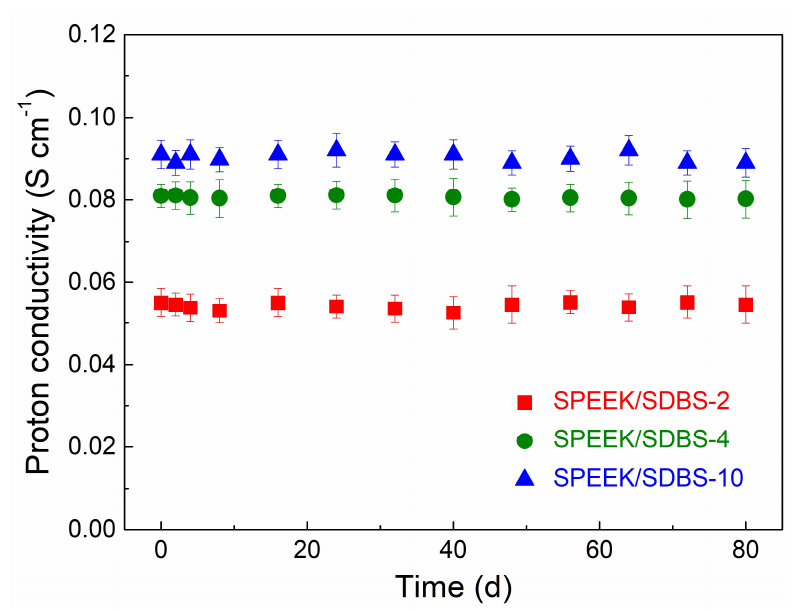
Figure 7. Proton conductivity of the SPEEK/SDBS-10 membrane as a function of immersion time in deionized (DI) water.